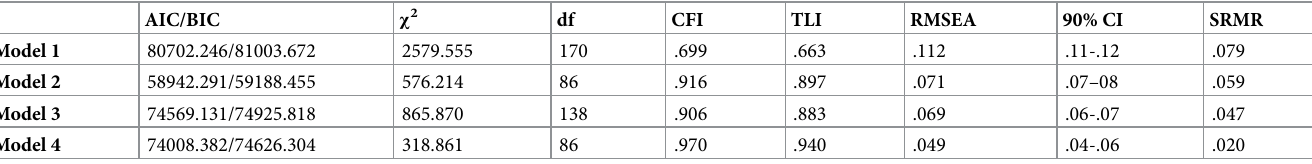
Table 2. Factor analyses of four measurement models of the Ruminative Thought Style Questionnaire.